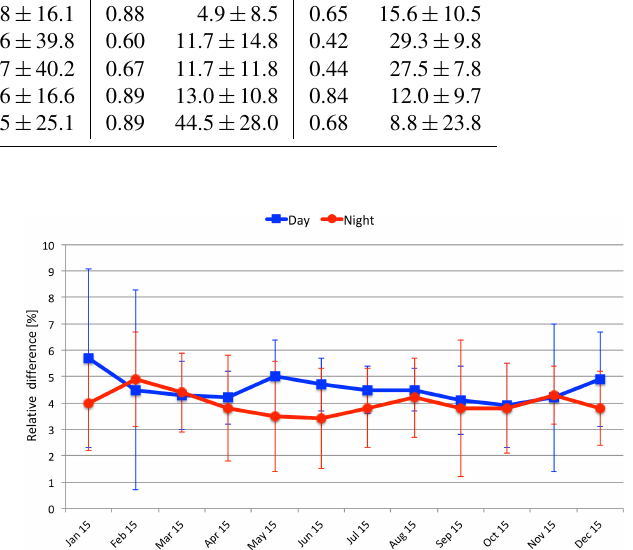
Figure 17. Global daily mean relative differences (in per- cent) between FORLI v20140922 and FORLI v20151001 to- tal ozone columns for daytime (blue) and nighttime (red) IASI measurements for 12 days in 2011 (on the 15th of each month). The relative difference is calculated as 100 × (v20140922 − v20151001) / v20151001.